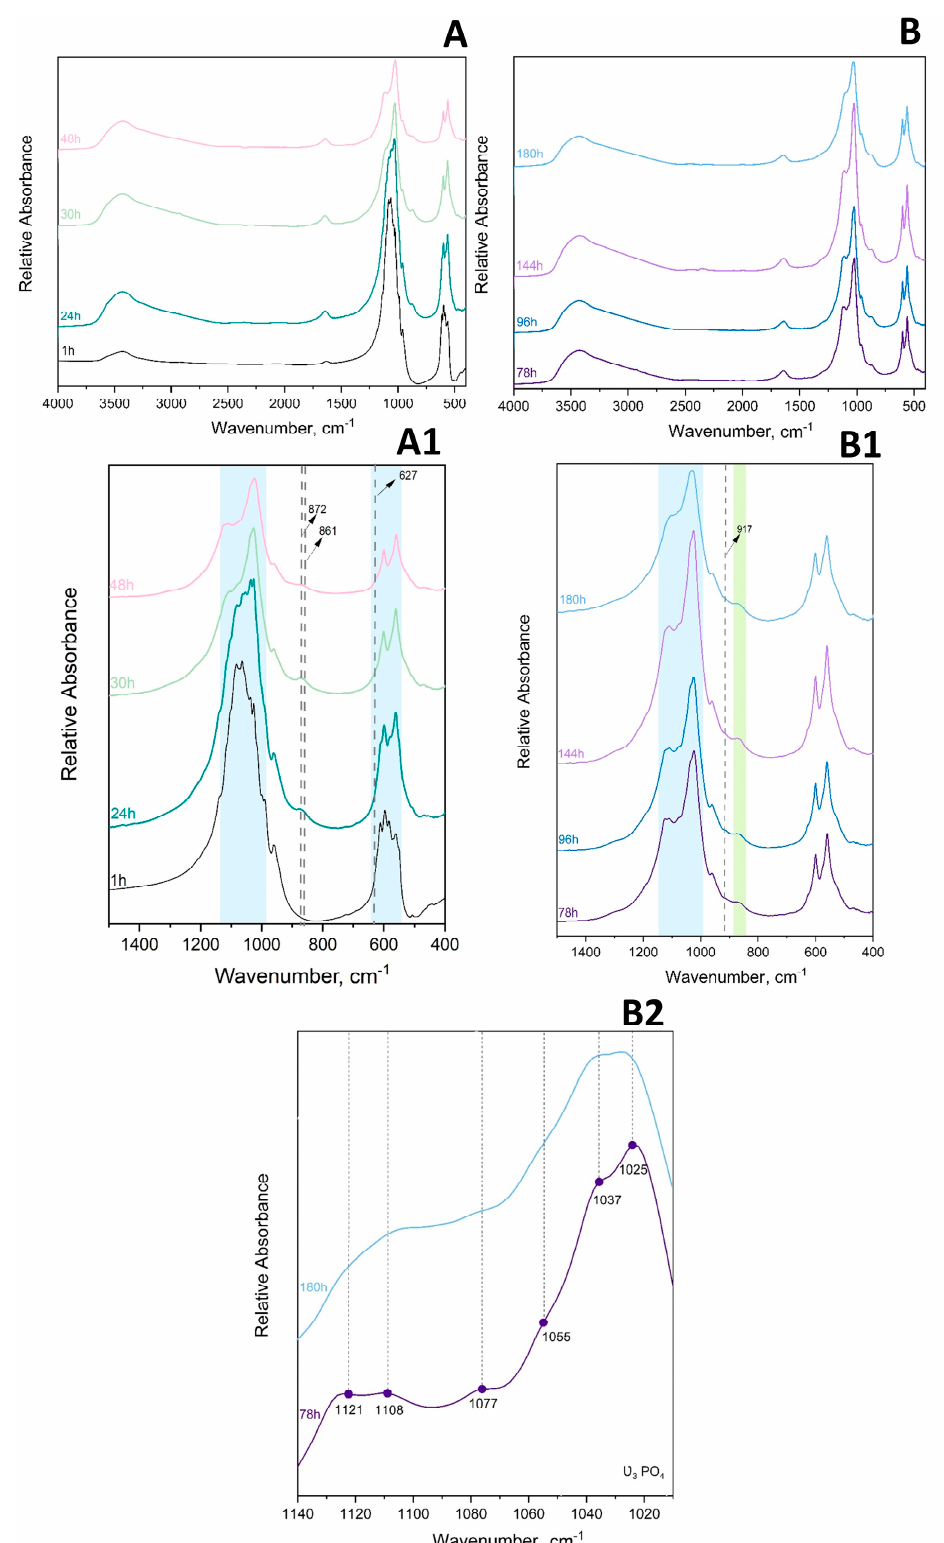
Figure 5. FTIR ( A , A1 ) absorbance spectrum of 1 h–48 h 100 × SC and ( B , B1 , B2 ) of 78 h–180 h 100 × SC. Green shadowed area is marking the narrow range of HPO 4 (5, 6) P–OH stretch and blue shadowed area corresponds to PO 4 stretching.